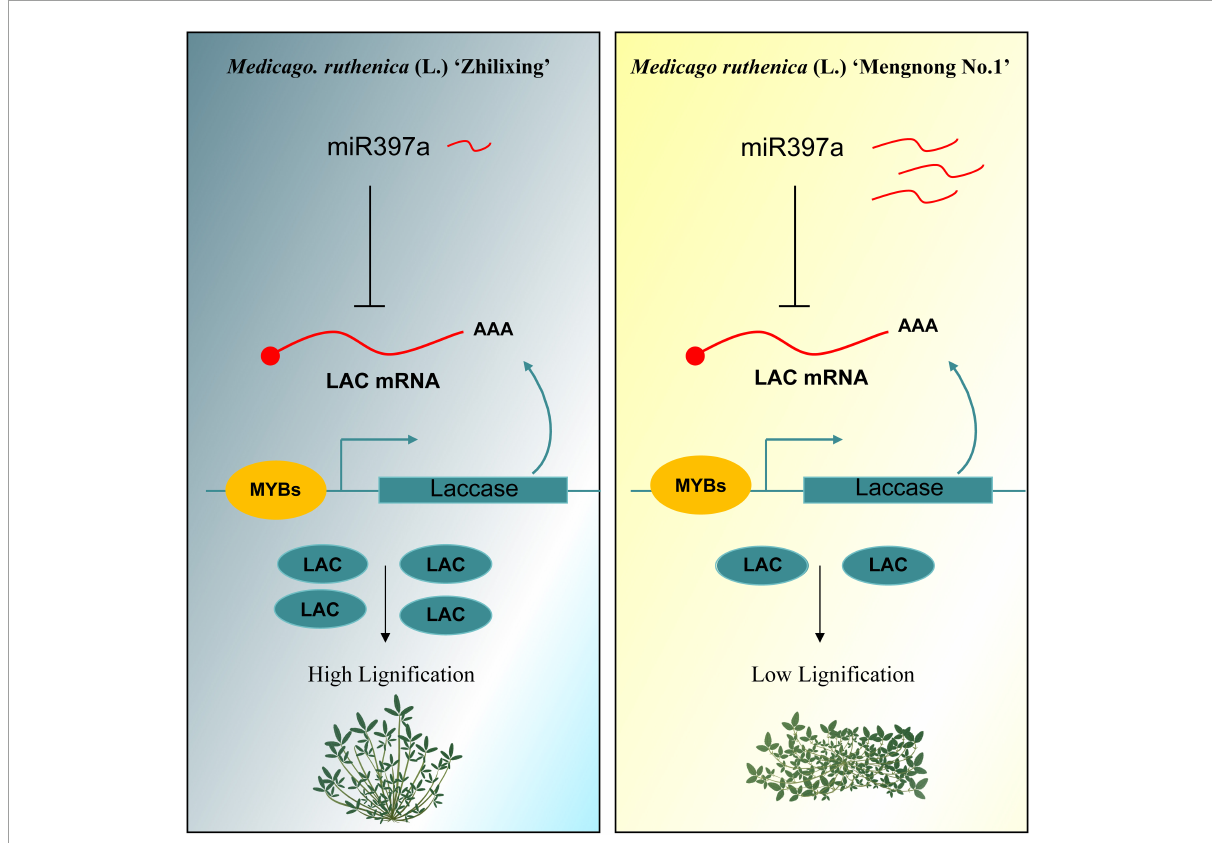
FIGURE8 The miR397a- LAC17 module regulates lignin content in M. ruthenica erect and prostrate stems. In the M. ruthenica cultivar Zhilixing (diagram on the left), miR397a is maintained at a low expression level, and negatively regulated LAC17 to a high expression level, thereby leading to enhanced lignin content and an erect-stem phenotype. In the right diagram, the cultivar Mengnong No.1 showed a miR397a- LAC17 module with the opposite expression level to